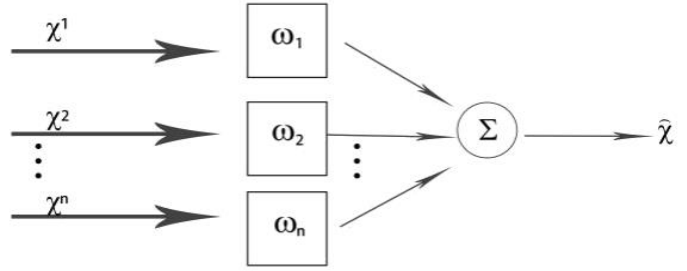
Figure 10. Adaptive weighted fusion algorithm model.